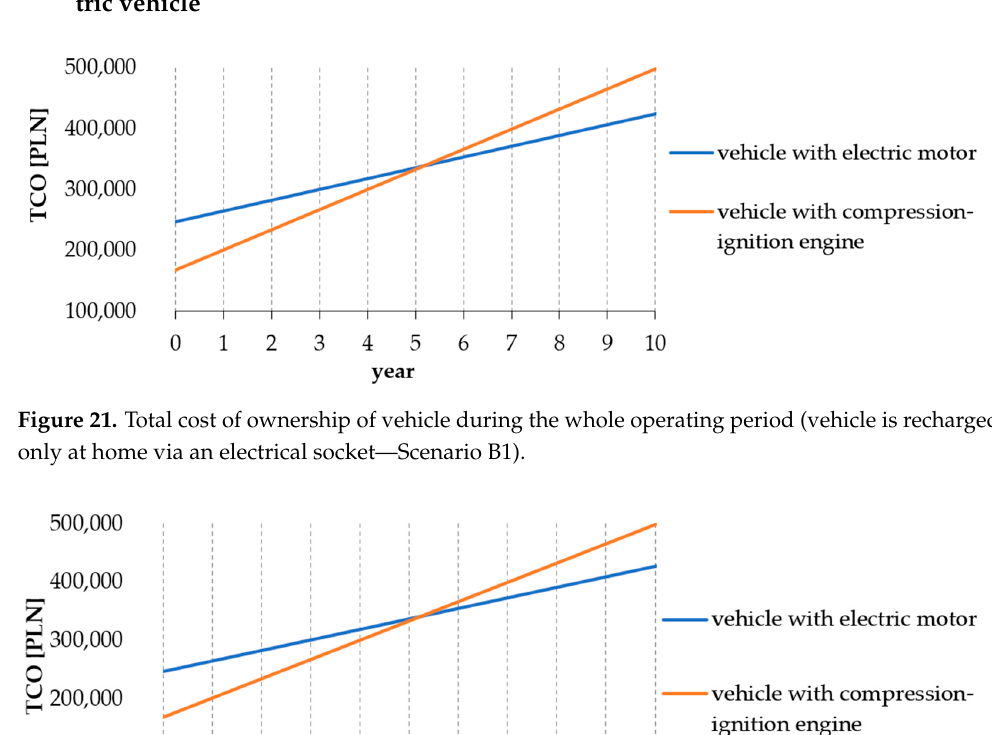
Figure 20. Total cost of ownership of vehicle during the whole operating period—electric vehicle is recharged only at public DC charging stations (the highest price for 1 kWh was included in the calculations—Scenario A5).